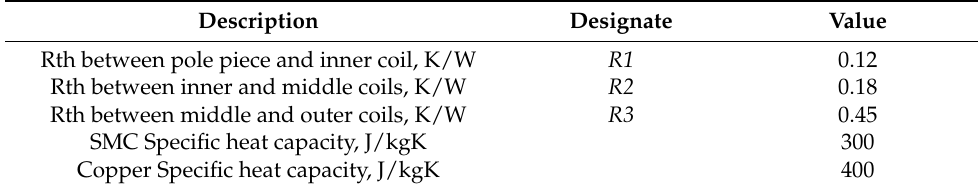
Figure 16. Thermal characterization of the model for a conventional pole piece and experiment conditions; also shown in Table 3, Test No. 1. Table 8. Experimental fit for R th for conventional windings.